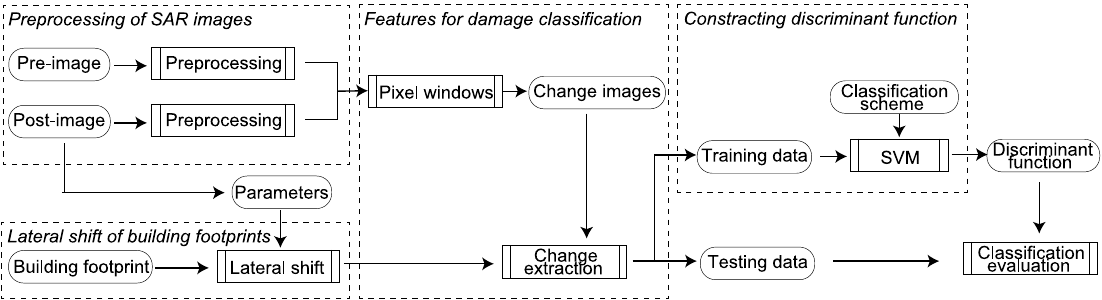
Figure 2. Schematic overview of the classification and performance evaluation